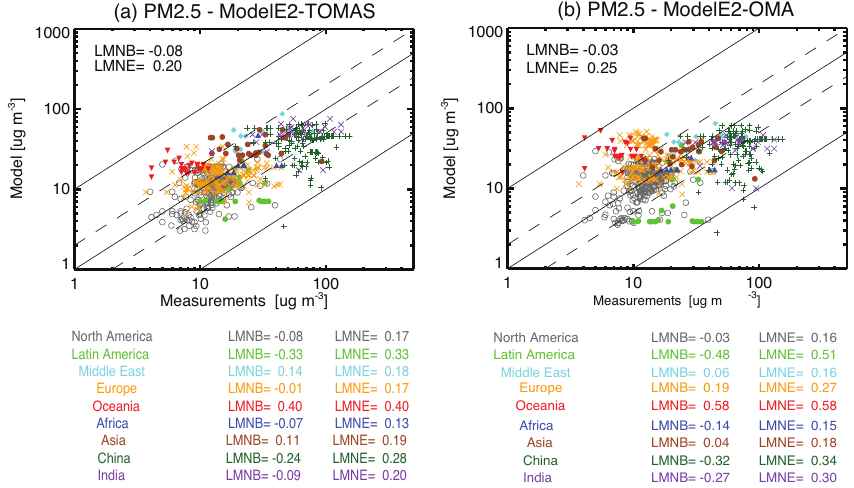
Figure 16. Scatter plots of annually averaged surface PM 2 . 5 concentration (µgm − 3 ) simulated and observations compiled by the Global Burden of Disease (GBD) study. ModelE2-TOMAS is shown in (a) and ModelE2-OMA in (b)